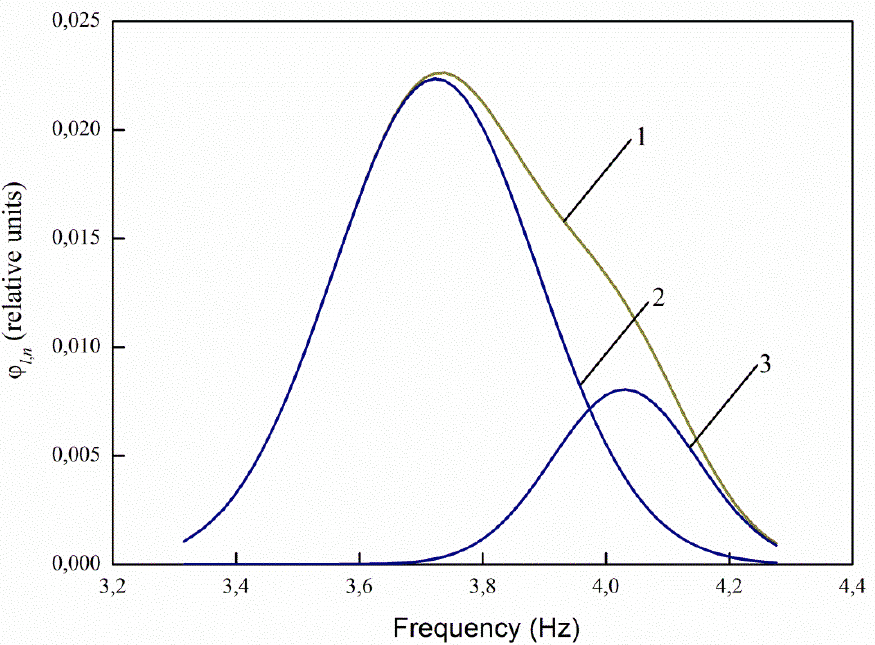
Figure 10. The spectral characteristic of the luminescence of infected wheat changeover at λ e,1 = 232 nm (1), decomposition by Gaussian curves (2) and (3).